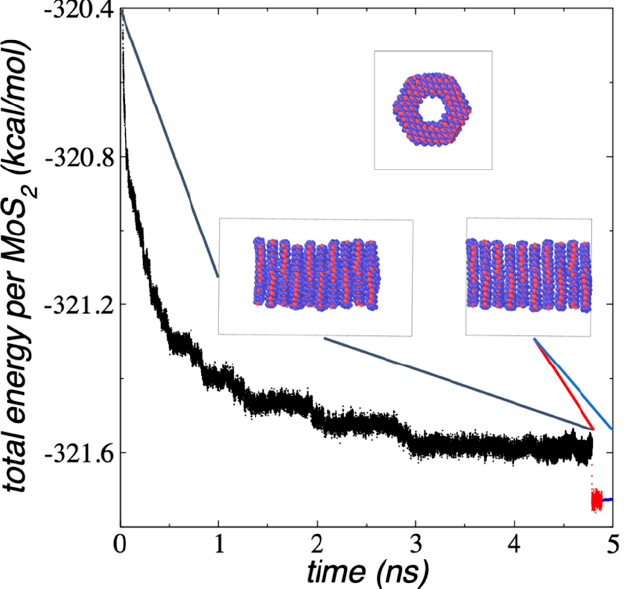
Figure 11. E #MoS2 of the Mo 108 S 216 -Mo 27 S 54 , 10L nanotube with 2H orientation as a function of the simulation time, under vacuum and NVT conditions at 298.15 K (black points), as a periodic nanotube at NVT conditions at 298.15 K (red points) and as a periodic nanotube under NVE conditions (blue points). The inset snapshots correspond to normal (top) and lateral (bottoms) views of the nanotube. Black lines in the bottom snapshots correspond to the actual limits of the periodic simulation cells. Blue and red spheres represent Mo and S atoms, respectively.